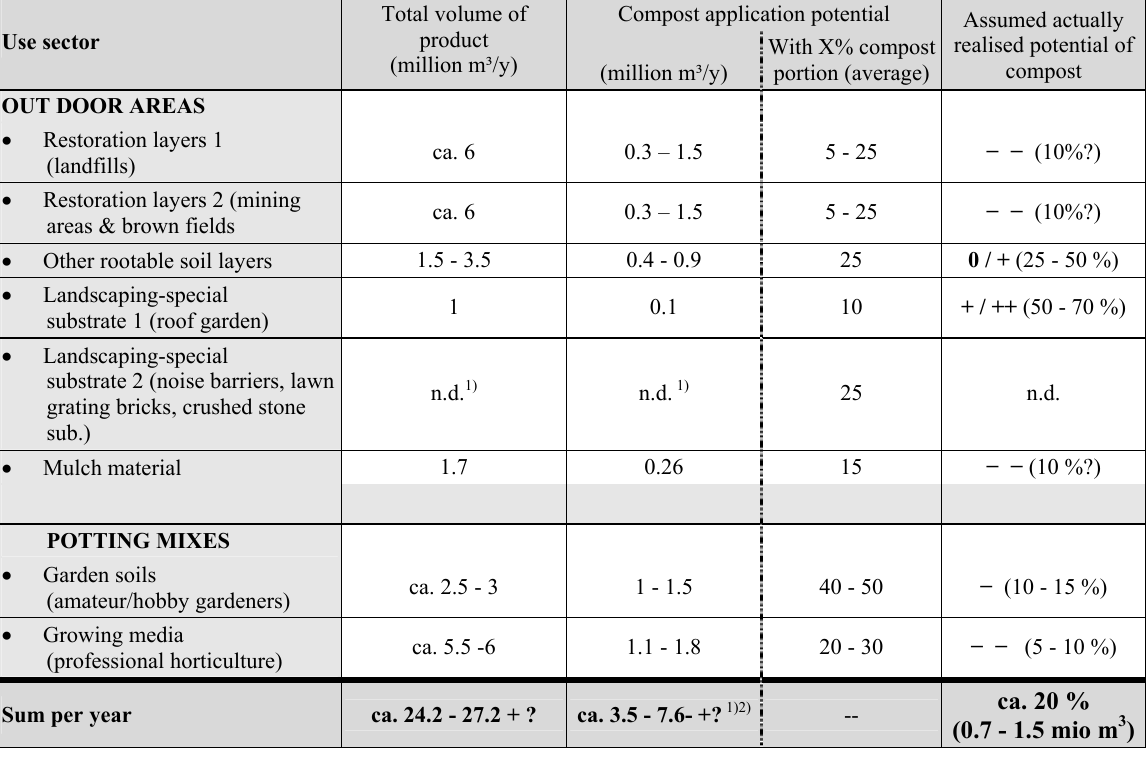
Table 50: Potentials of compost markets with regard to vegetation layers, growing media and culture substrates Compost application potential Total volume of Assumed actually realised potential of